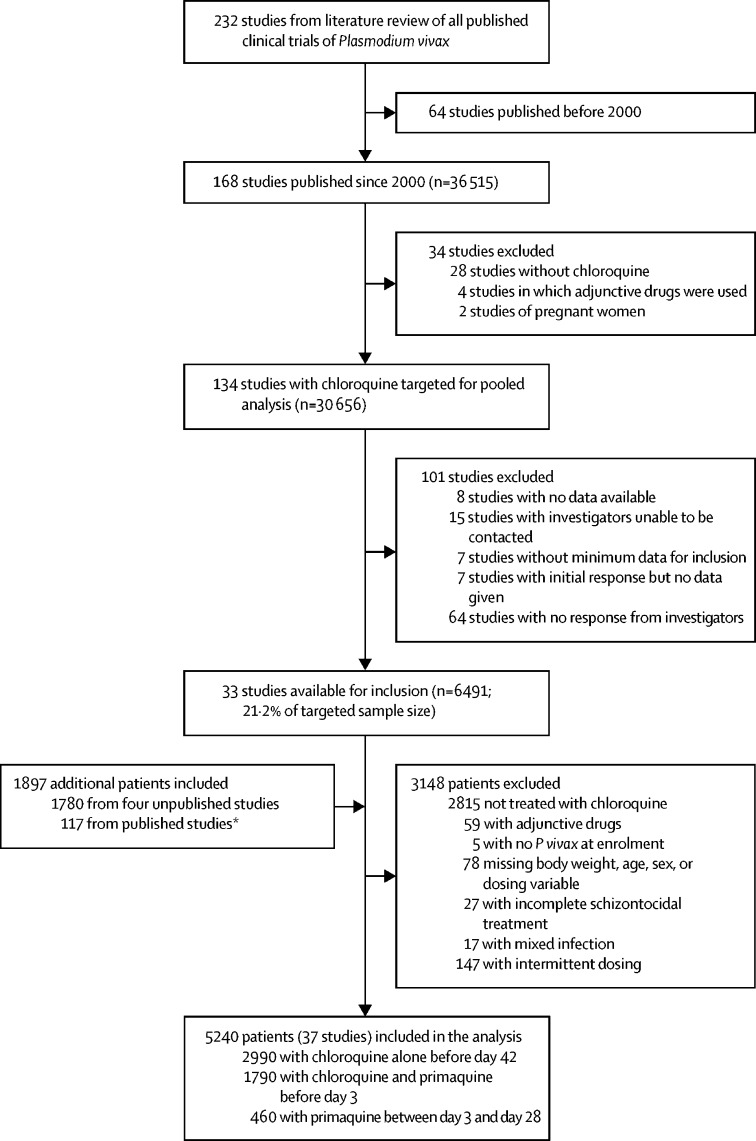
Study profile*Additional patient data available from published studies that were not described in the published enrolment cohorts.